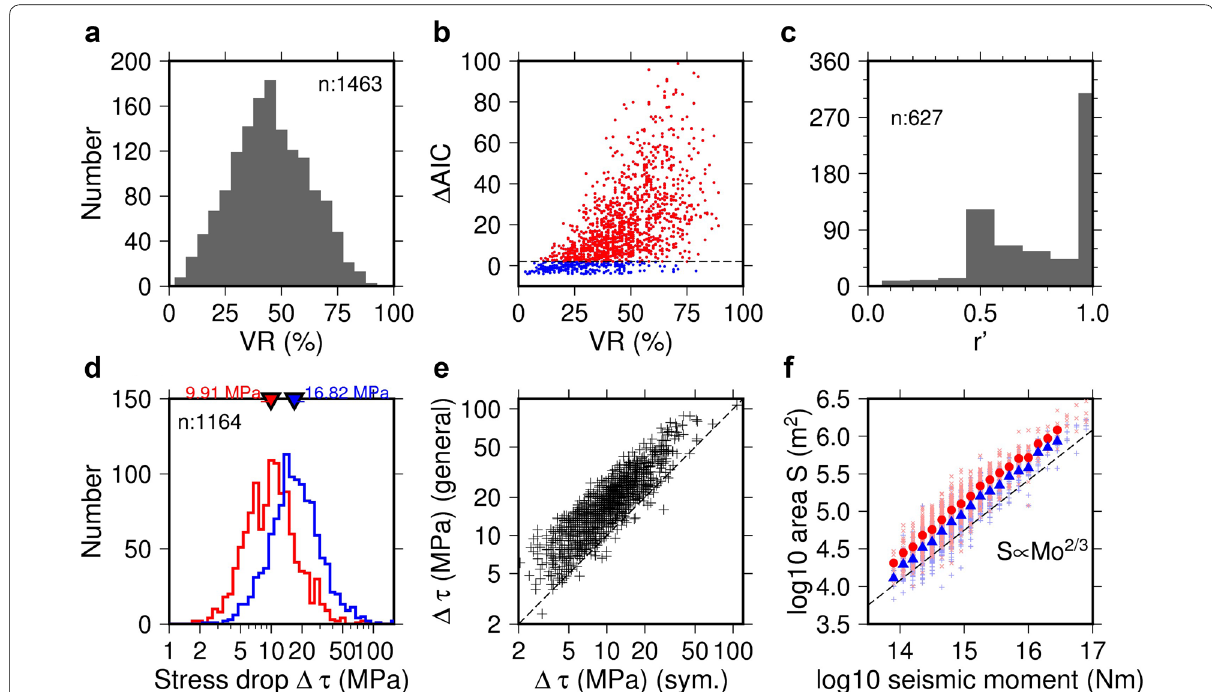
Fig. 3 Results of fitting the asymmetrical rupture model. a Frequency distribution of variance reduction (VR). b Comparison between VR and (cid:31) AIC . Red and blue circles show (cid:31) AICs greater and less than 2, respectively. c Frequency distribution of r ′ . d Frequency distribution of stress drop. Blue and red lines indicate the results of the asymmetrical and symmetrical rupture models, respectively. e Comparison between the stress drops based on the asymmetrical and symmetrical rupture models. f Fault area compared with the seismic moment. Blue and red symbols indicate the results of the asymmetrical and symmetrical rupture model,